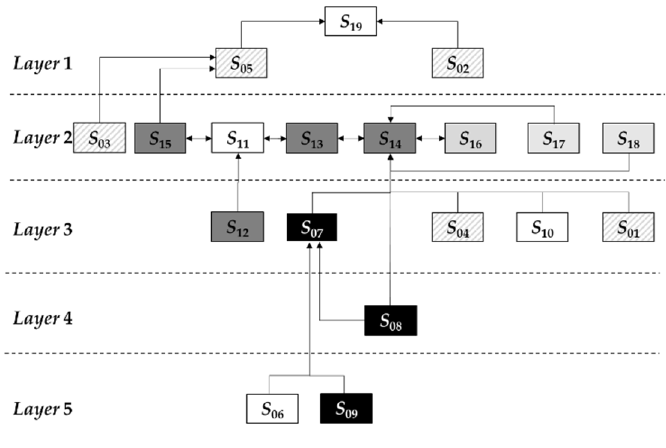
Figure 8. Results of FCE and ISM.